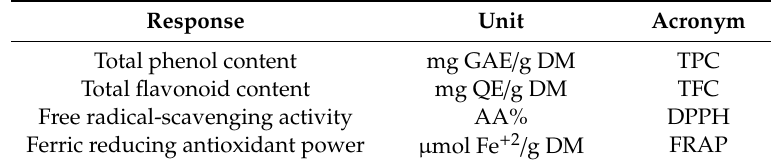
Table 2. Responses set in the UAE experimental